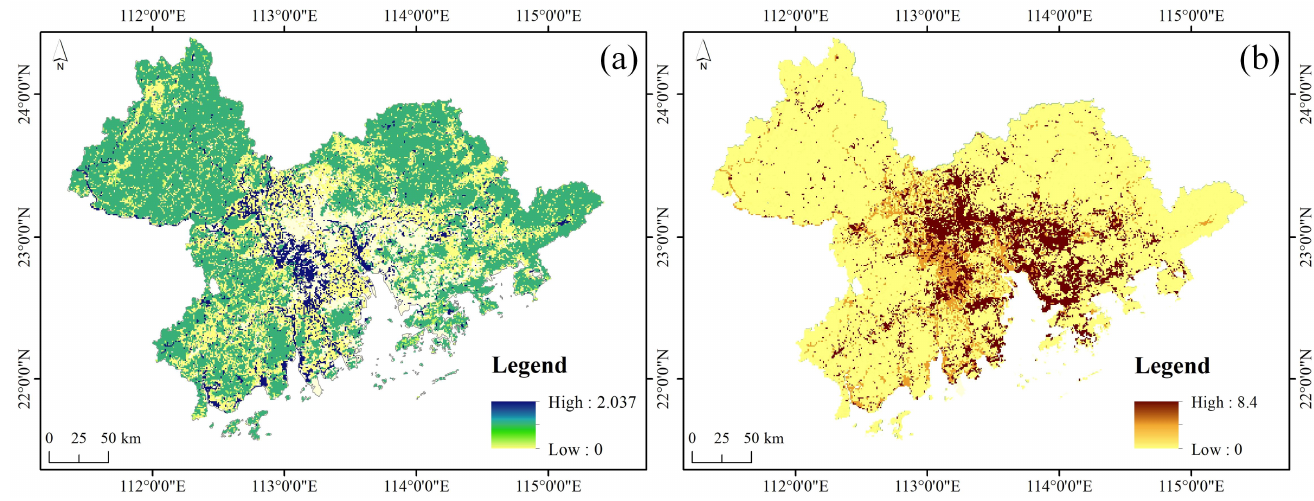
Figure 9. The initial spatial distribution of ESV ( a ) and GDP ( b ). Table 3. The unit ESV and GDP in each land use type.